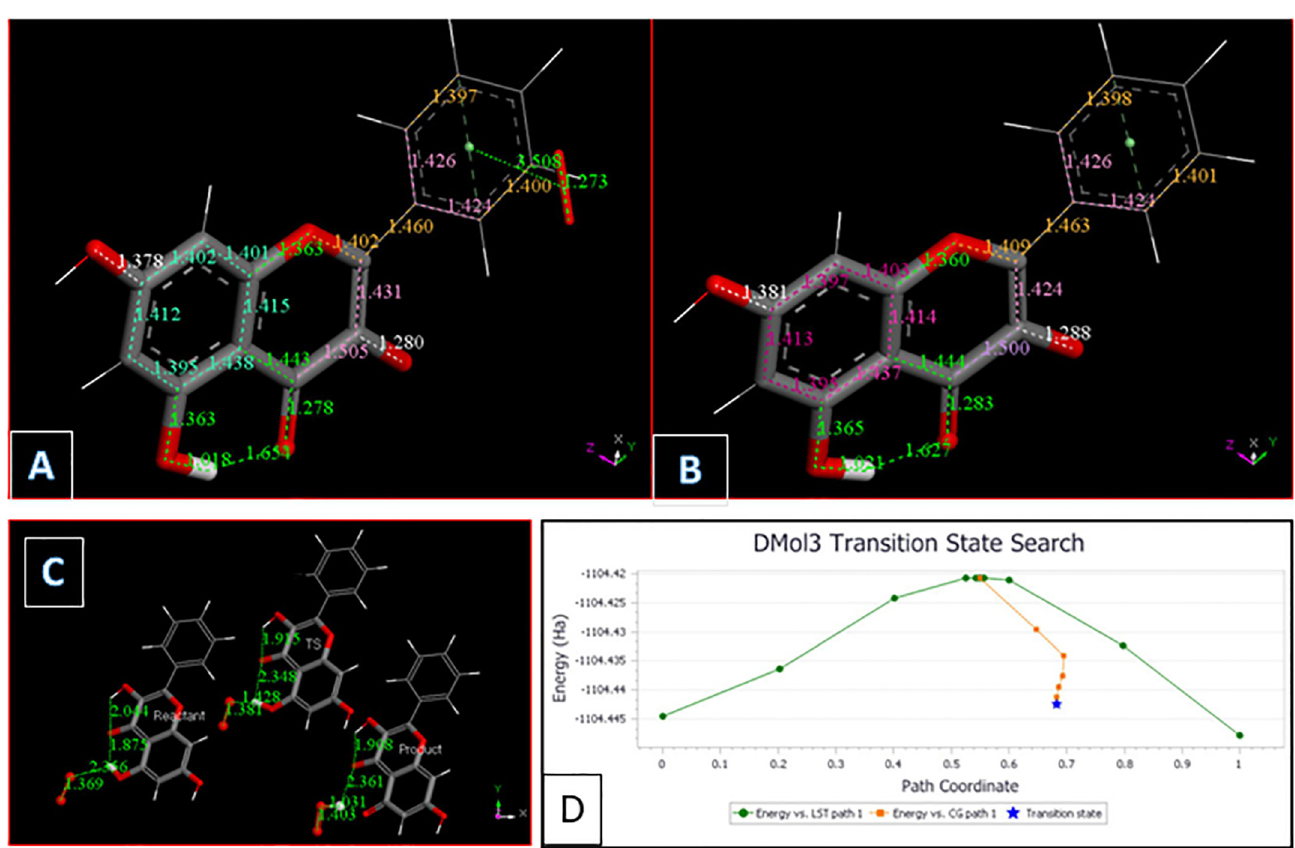
Fig 6. A: The π - π approach of a superoxide to galangin ring B allows for ring capture of its unpaired electron. O-O bond distance becomes similar to that in molecular oxygen, 1.273 Å , in contrast with the approached superoxide O-O, 1.373 Å . B: From previous Fig 6A O 2 is eliminated and DFT minimization is performed; C: Reagent, TS and Product for galangin H5 extraction by superoxide. Δ G = -2.067 kcal/mol, E(barrier) = 1.3 kcal/mol; D: TS profile for galangin H5 extraction by superoxide. Δ G = -2.067 kcal/mol, E(barrier) = 1.3